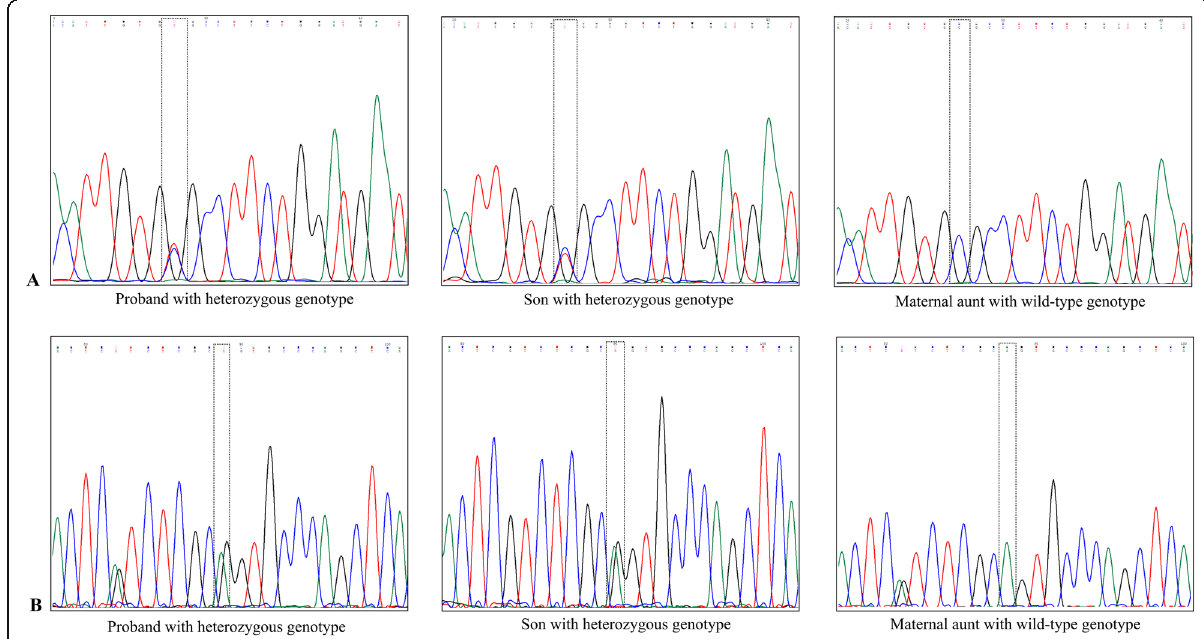
Fig. 1 Sanger sequencing of A NOTCH2 and B SDK2 variants in proband, son and aunt by maternal